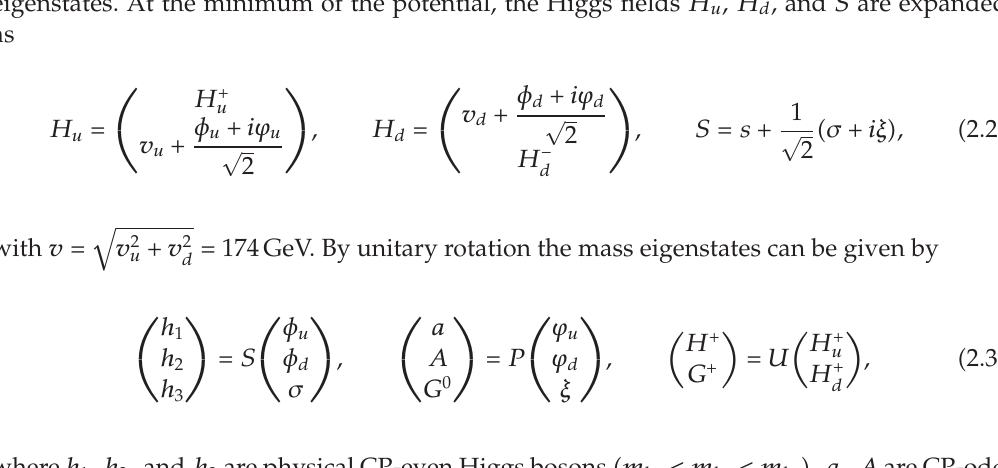
identical to the NMSSM with κ (cid:7) 0, except for the minimization conditions of the Higgs potential and the tree-level Higgs mass